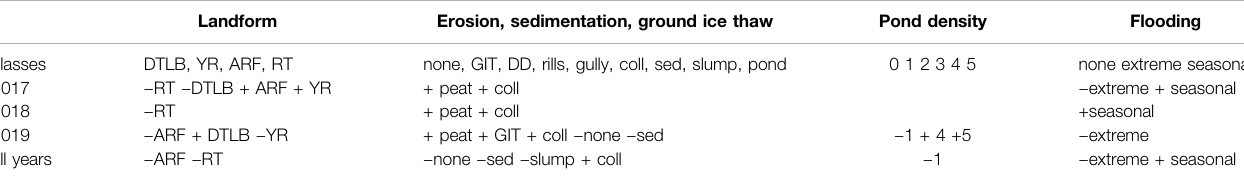
TABLE3| Categoricalvariablesandtheirclassesusedinanova,andmulti-comparison(Tukey-Kramer)testresultsofdifferencesbetweenclassesforeachyearsandsumof all years. Landform Erosion, sedimentation, ground ice thaw Pond density Flooding none, GIT, DD, rills, gully, coll, sed, slump, pond 0 1 2 3 4 5 none extreme seasonal 2017 − extreme + seasonal